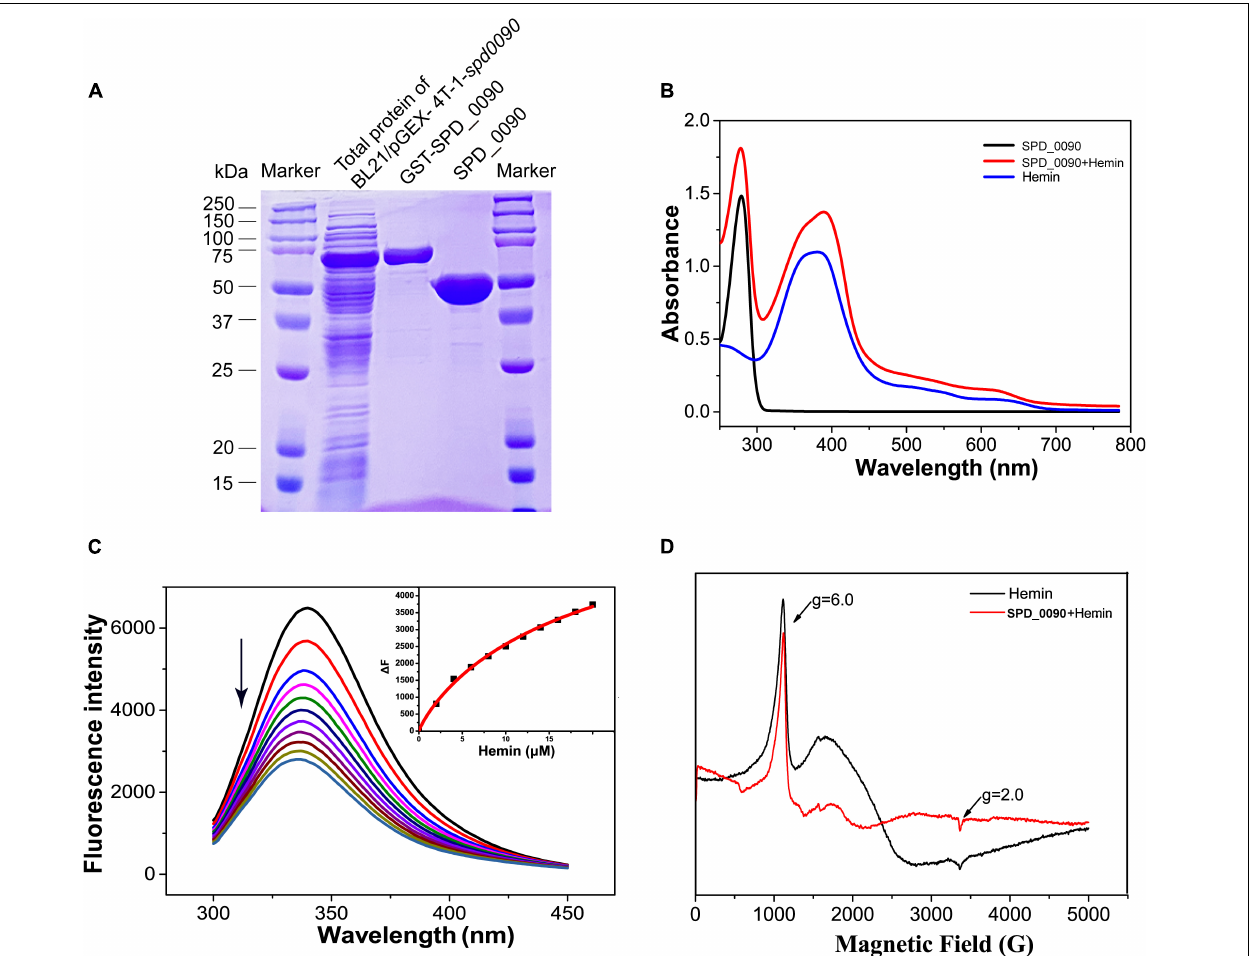
FIGURE 5 | SPD_0090 binds to hemin in vitro . (A) SPD_0090 was expressed with pGEX-4T-1-GST fusion system and purified by Glutathione Sepharose. (B) UV/vis spectra of the SPD_0090, Hemin, SPD_0090 + Hemin. The protein concentration is 25 µ M and the spectra were scanned from 200 to 600 nm. (C) Fluorescence spectra of hemin titration to SPD_0090 (2 µ M). (D) EPR spectrum of SPD_0090 in combination with hemin and hemin alone. All experiments were repeated three times. Statistical analysis was conducted using Origin version